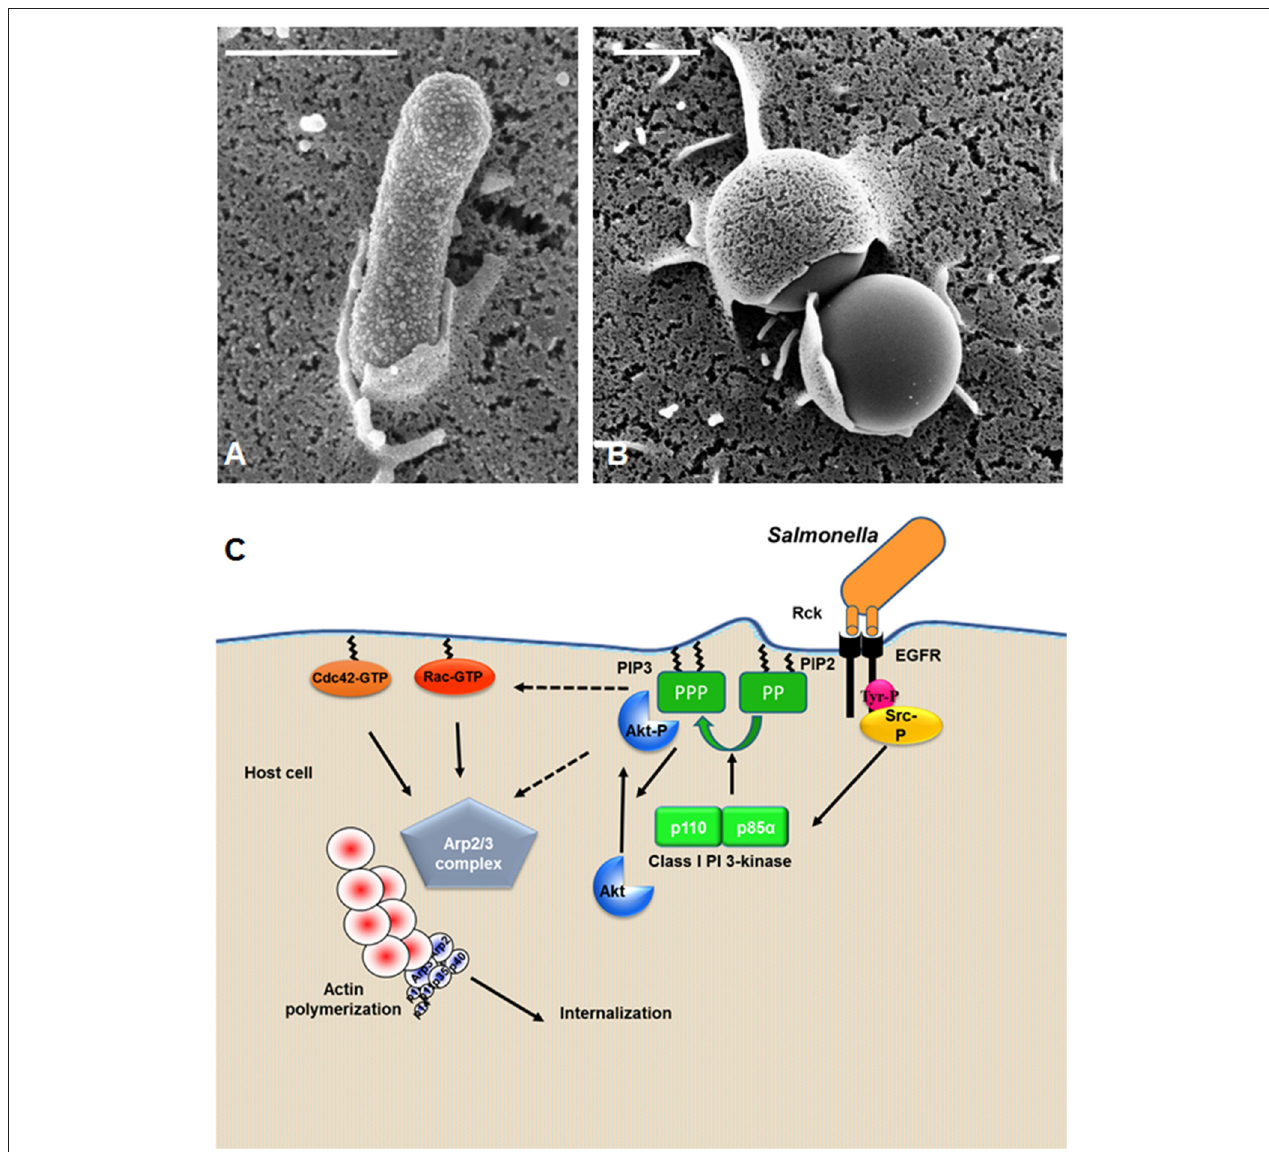
FIGURE 3 | Mechanism of Salmonella entry mediated by Rck invasin. (A,B) Scanning electron microscopy of zipper mechanism induced by Rck. Human choriocarcinoma (Jeg-3) cells infected with (A) E. coli overexpressing Rck; (B) Rck-coated beads. (A,B) Bar = 1 µ m. (C) A model of Rck-mediated intracellular signaling cascade leading to Salmonella internalization. The interaction of Rck with the EGFR induces a cellular signaling pathway, leading to internalization. The signaling cascade requires different cellular proteins such as c-Src kinase, PI3-kinase, Akt, Cdc42 and Rac GTPases, the Arp2/3 complex and actin. Dotted arrows: possible interactions and/or signaling